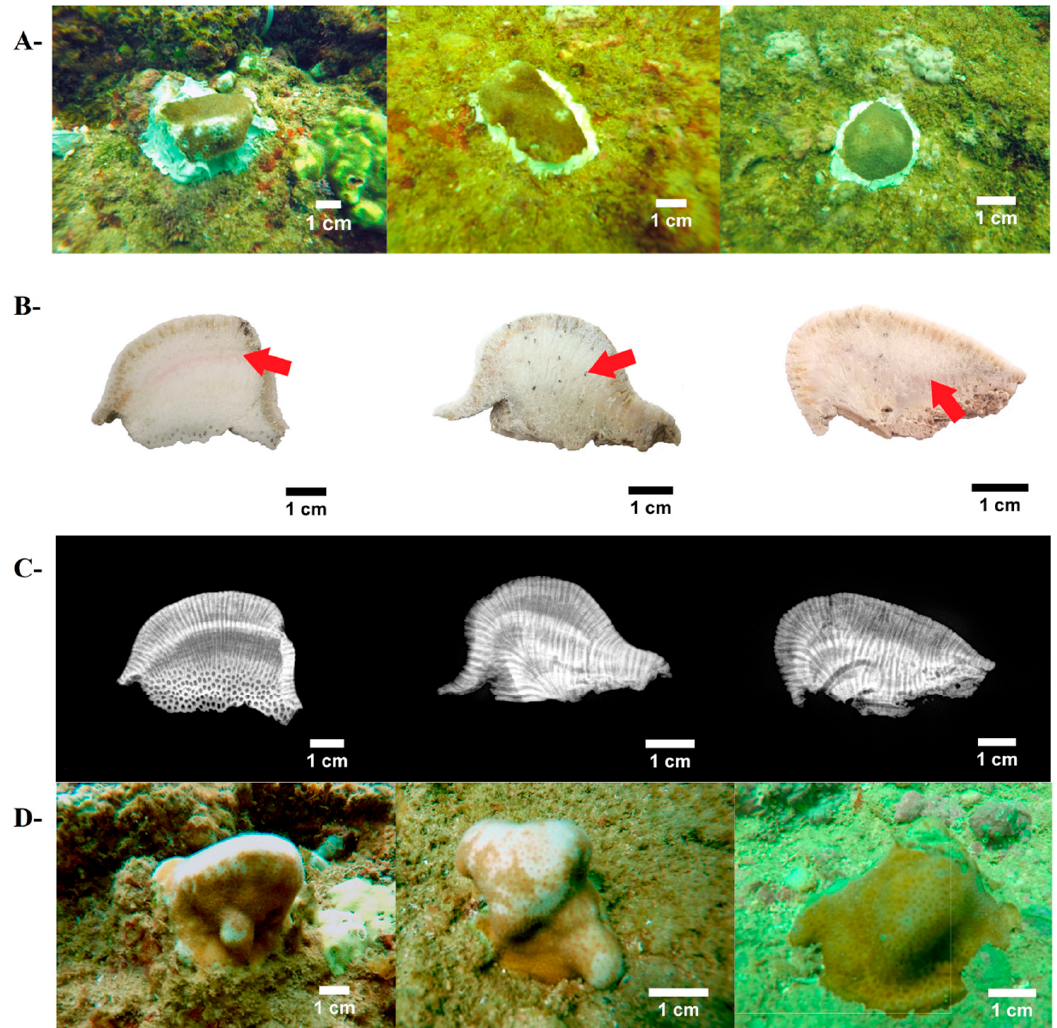
Figure 2. The use of micro-fragments of Pavona clavus from Islas Marías Cleofas for coral reef restoration. ( A ): micro-fragments at onset, just glued to the substrates; ( B ): coral skeleton slabs exhibiting Alizarin red marks (red arrows); ( C ): X-ray images of coral skeletons displaying annual bands pattern (light/dark shade = low/high density): ( D ): final coral size of the same colonies as in part A, 13 months later.